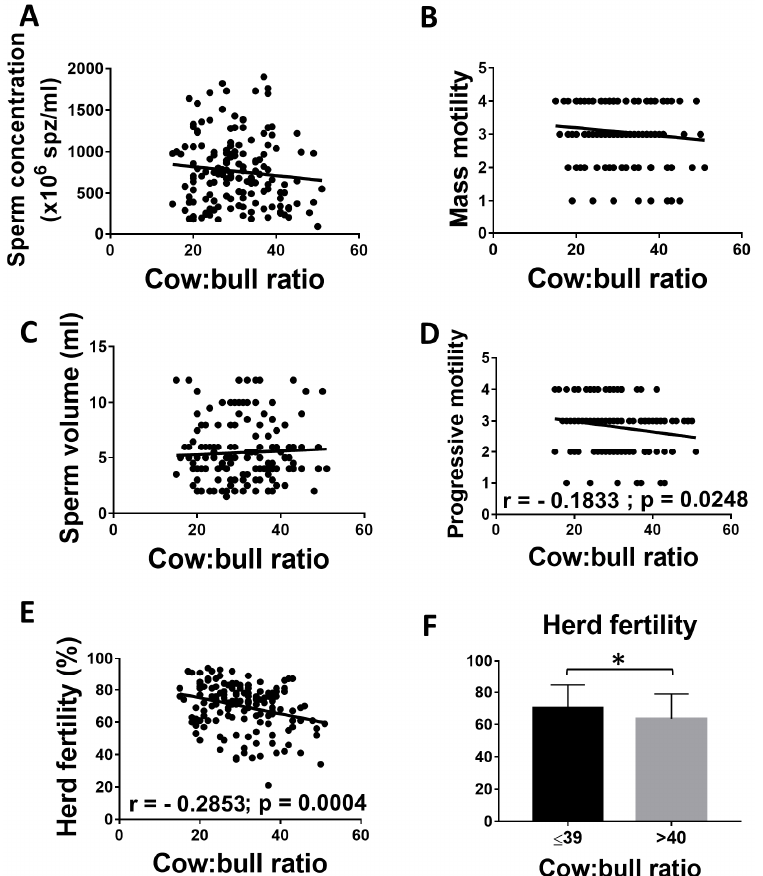
Figure 4. Correlation between cow: bull ratio and the fertility of the herd. ( A – E ) Linear regression between cow: bull ratio and reproductive parameters. ( F ) Mean and SEM of herd fertility of bulls with 40 or more cows and with less than 40 cows. * indicates statistically significant differences, t -test ( p < 0.05).